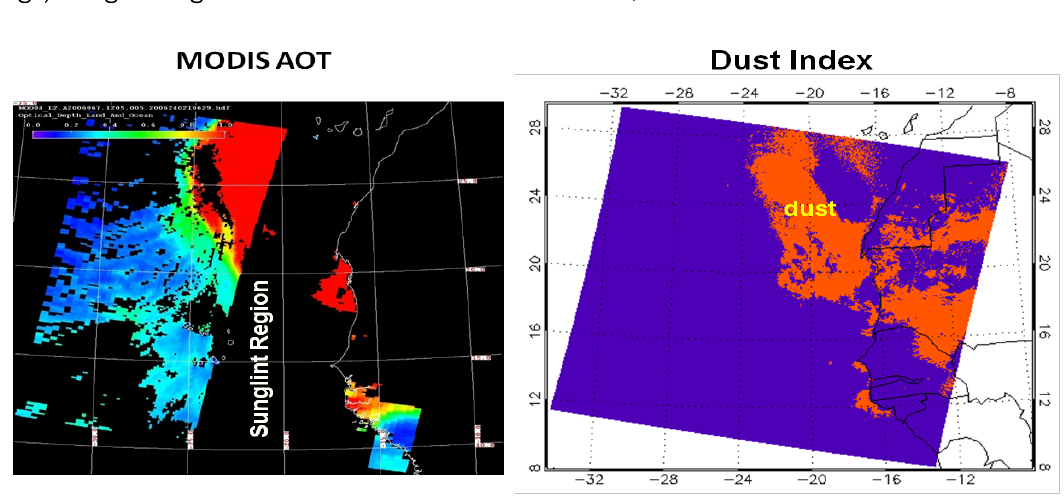
Figure 20. Comparison of MODIS AOT retrieval (left panel) with the dust detection result (right panel) for the case of Figure 16. There is no MODIS AOT retrieval for bright areas (e.g., sun glint region over ocean and desert over